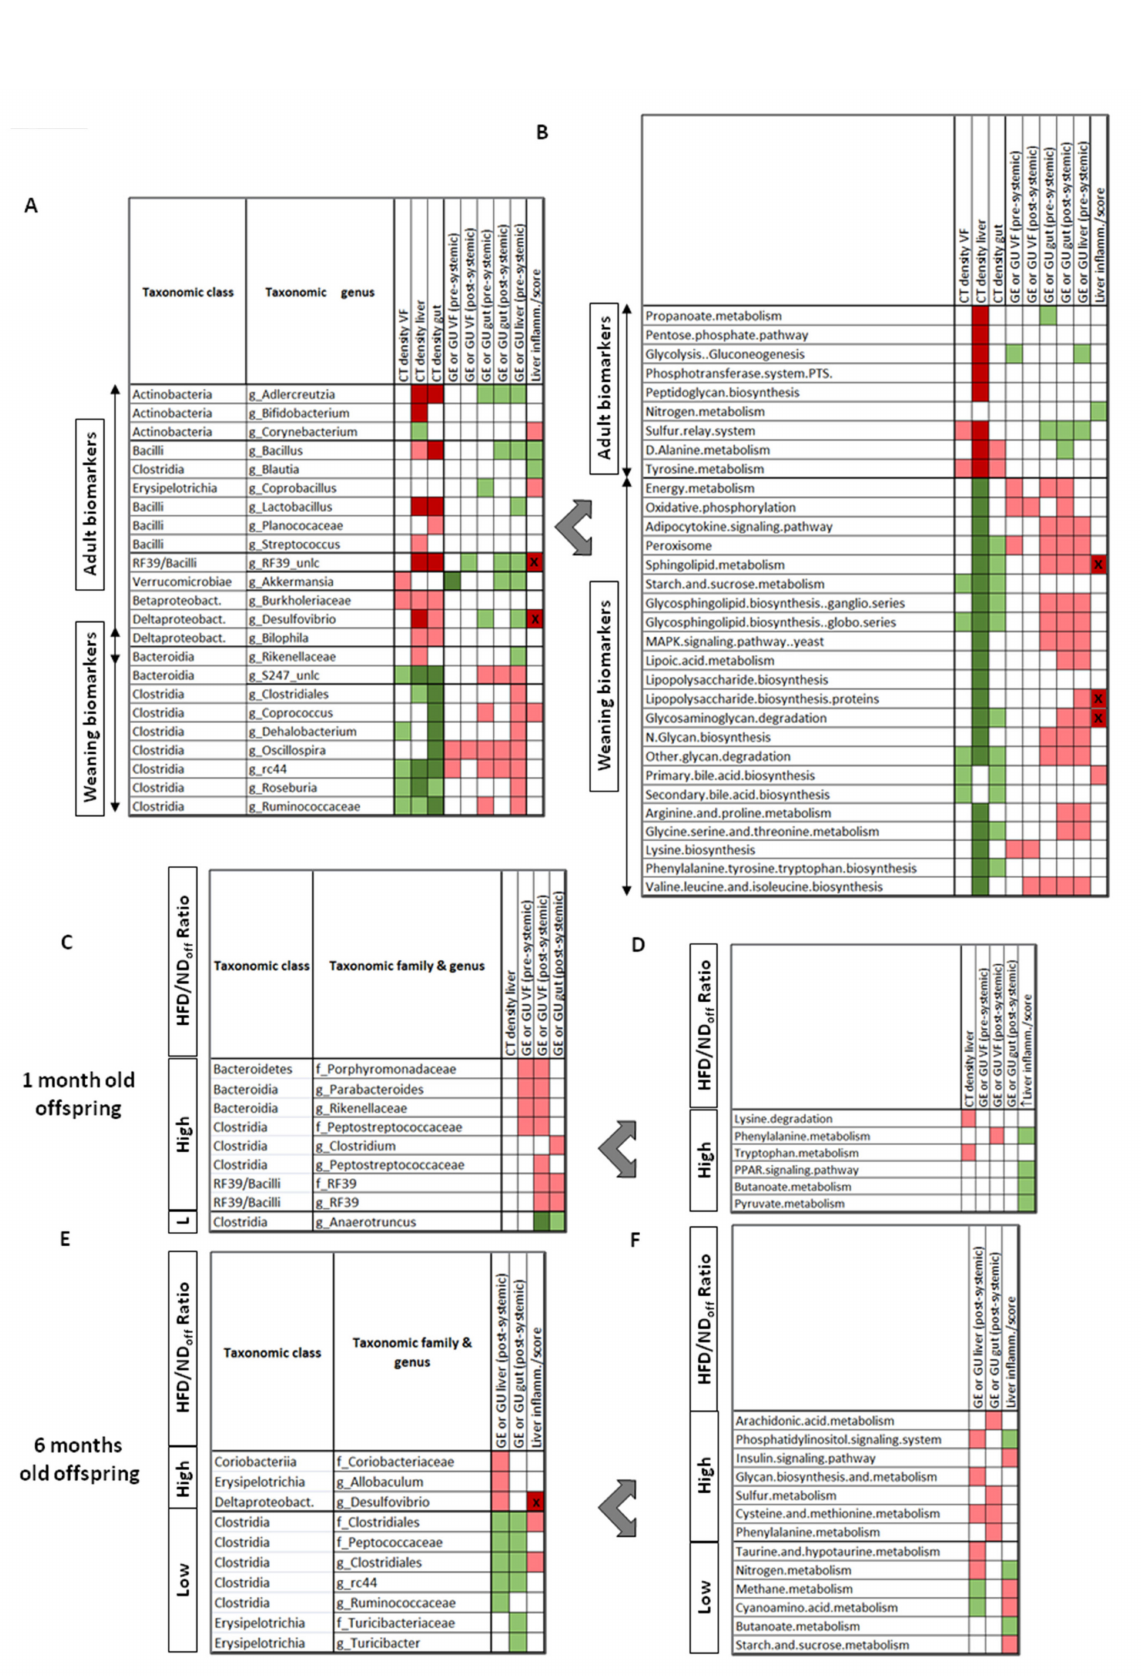
Figure 3. Relationships linking microbiota (left panels) or metabolic pathways (right panels) biomarkers and tissue imaging results (dependent variables), as observed by age ( A , B ), or by maternal diet*age (weaning mice ( C , D ), adult mice ( E , F